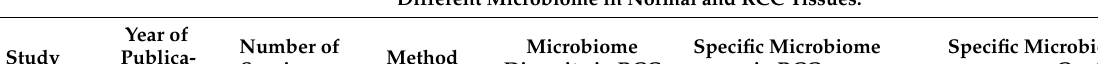
Table 1. Cont. Different Microbiome in Normal and RCC